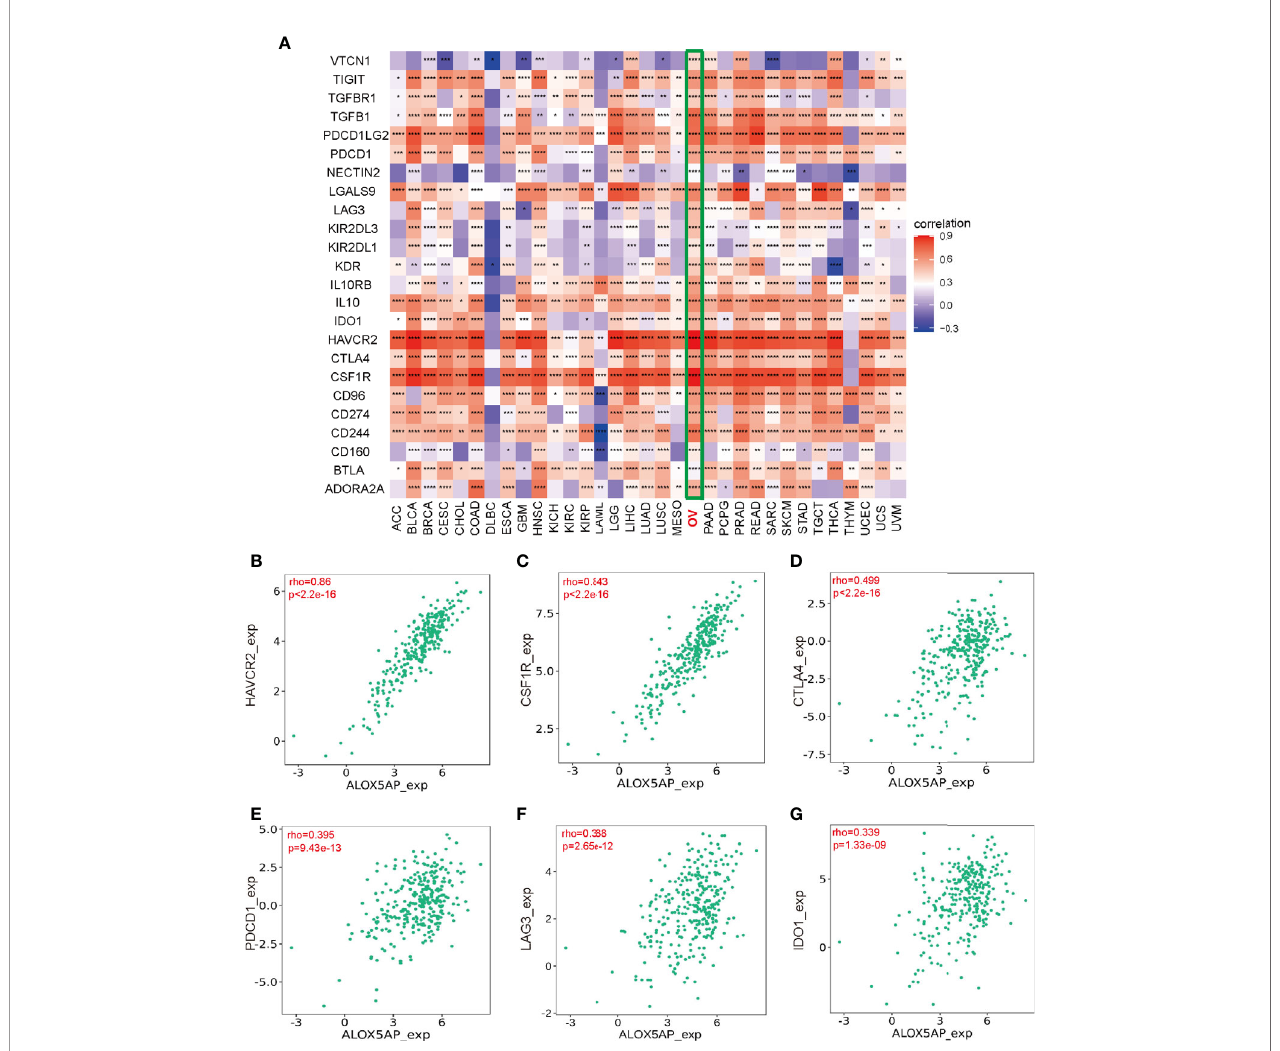
FIGURE 8 | Association between Immunosuppressors and ALOX5AP expression in SOC. (A) Co-expression heatmap of ALOX5AP and immune inhibitory molecules across 33 TCGA tumor types. (B – G) Spearman correlation analysis of ALOX5AP and individual immune suppressive molecule in SOC. (*p < 0.05, **p < 0.01, ***p < 0.001, ****p <